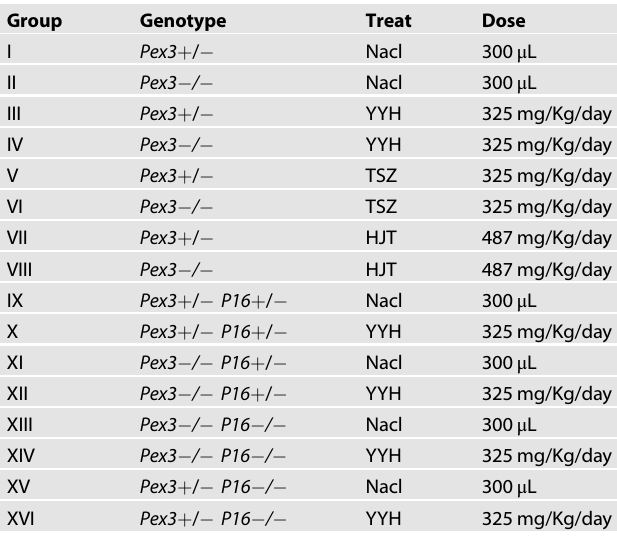
Fig. 5 Detection of the expression levels of senescence pathway-related proteins after YYH supplementation. ( n = 3). A Western blot results for P16-Rb and P53-P19 signaling-related proteins. B Grayscale values. Table. 1. Design of the